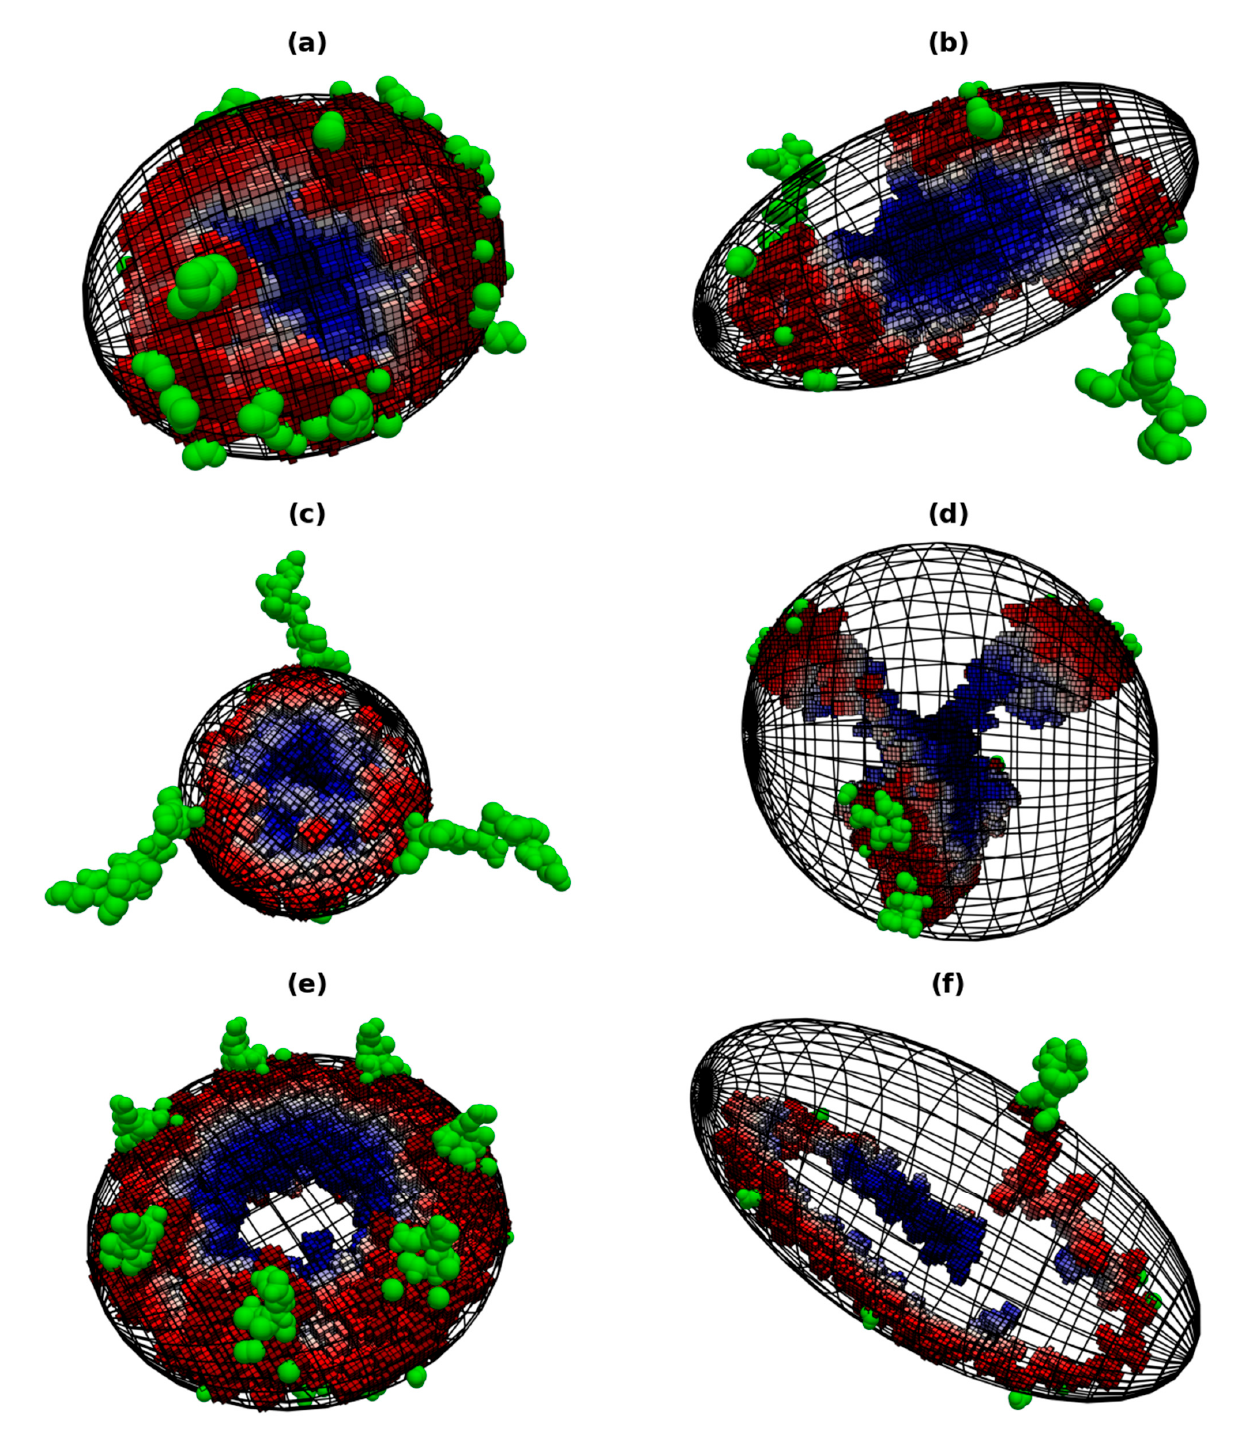
Figure 4. Results of voxelization of six example proteins using m = 3: Endoglucanase A (1IS9, monomer) ( a ), Hypothetical Protein Atu1913 (2B1Y, dimer) ( b ), HLA-DR Invariant Chain (1IIE, trimer) ( c ), ribosomal protein L9 (1DIV, dimer) ( d ), Uncharacterized Protein (3BPD, heptamer) ( e ), Alpha-synuclein (2KKW, monomer) ( f ). Colors of voxels represent values of Equation (1): blue—towards ellipsoid’s center, red—towards ellipsoid’s surface. Their range is the same as the range of colors in Figure 3d. Green spheres are atoms of the protein located outside the MVEE.